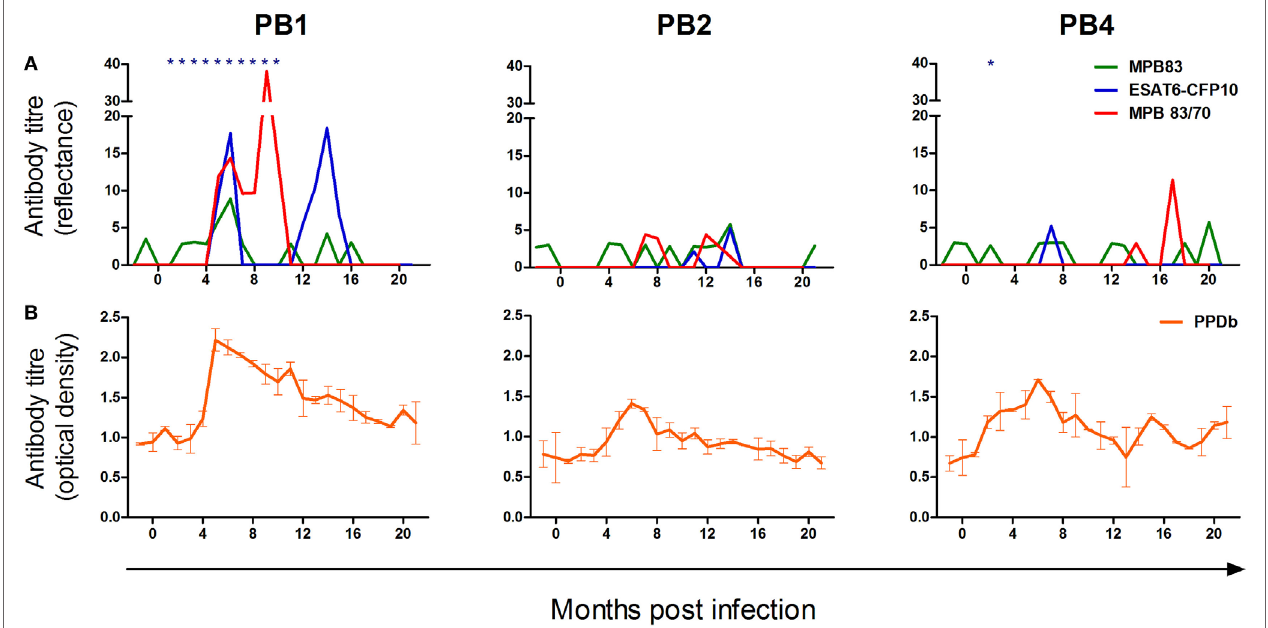
FigUre 2 | The kinetics of the humoral response to Mycobacterium bovis infection in the white rhinoceros. Following M. bovis infection, serum antibodies of three animals (PB1, PB2, and PB4) were measured using selected commercial assays and an in-house bovine purified protein derivative (PPDb) enzyme-linked immunoassay (ELISA). (a) Serological responses to MPB83 and 6 kDa early secretory antigenic target (ESAT-6)/10 kDa culture filtrate protein (CFP-10) (Dual Path Platform (DPP) ® VetTB assay) and MPB83/70 (Bovid DPP assay); seroreactivity to ESAT-6/CFP-10/MPB83 (ElephantTB STAT-PAK ® assay) is indicated (*). (B) Serological responses to PPDb, measured in duplicate by indirect ELISA, and calculated as the difference in optical density (OD) between control wells and PPDb-coated wells (mean Δ OD ±